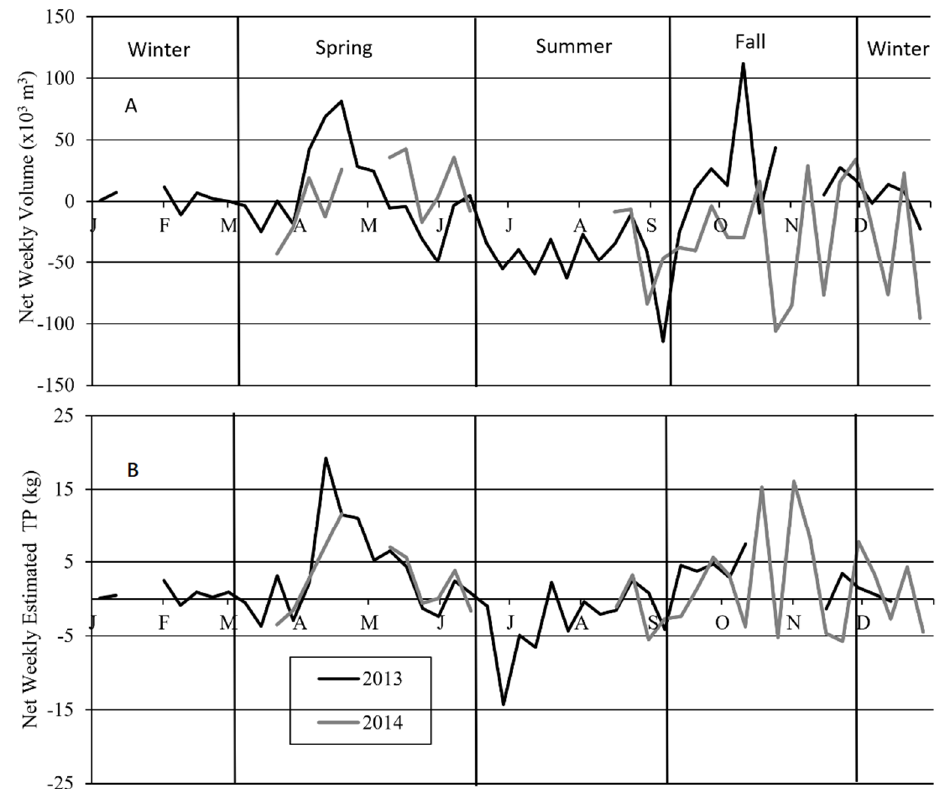
Figure 3. Net flux (difference between inflow and outflow) for ( A ) water volume (×1000 m 3 ) and ( B ) weekly estimated total phosphorus (TP) (kg) between the Pool 2B wetland and Crane Creek for 2013 and 2014 at the Ottawa Wildlife Refuge, Oak Harbor, OH. Positive values indicate flux into the pool, and negative values flux out of the pool. Table 1. Number of weeks sampled (n), Net (difference between inflow and outflow), weekly seasonal mean, and standard error of the mean (SE) for estimated total phosphorus (TP, kg) and water volume ( × 10 3 m 3 ) fluxes, for the four seasons (see text for description) at the Pool 2B wetland, Ottawa NWR, Oak Harbor, OH. Positive values indicate flux into the pool and negative values indicate flux out. See text for date ranges of seasons. Superscripts indicate which seasons are significantly different from each other (sp is spring, su is summer, f is fall, and w is winter), within a year one-way ANOVA ( p -value < 0.05). There were no differences between seasons in 2014 for estimated TP or volume. Estimated TP